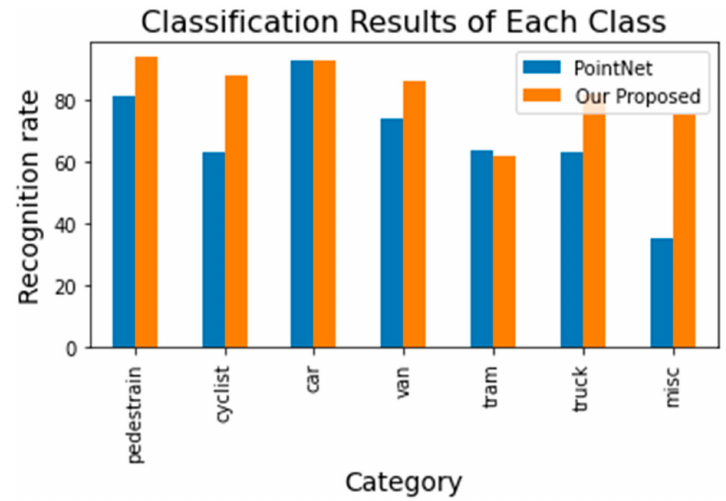
Figure 12. Comparison of our proposed MTMS with PointNet